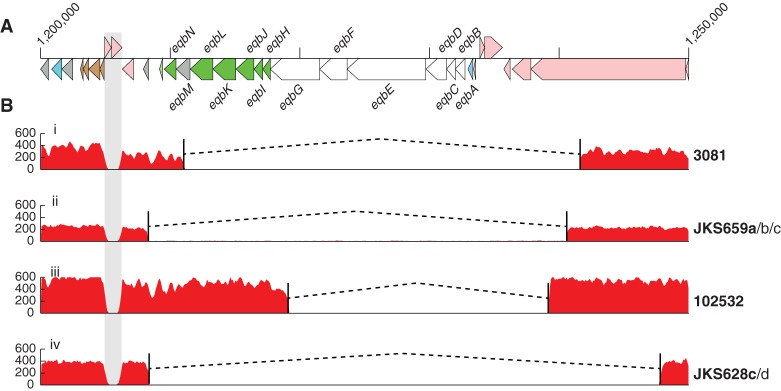
Convergent deletion of the equibactin locus in seven isolates recovered from four independent persistently infected horses. (A) A representation of the genome annotation around the equibactin cluster. (B) Read mapping of the equibactin locus in example isolates exhibiting the four deletion variants. Names to the right of the plots indicate isolates exhibiting the same deletion. Isolate names in bold are the examples used for the mapping plot. Read mapping drops to zero in the gray repeat region due to an inability to map reads uniquely to this region.